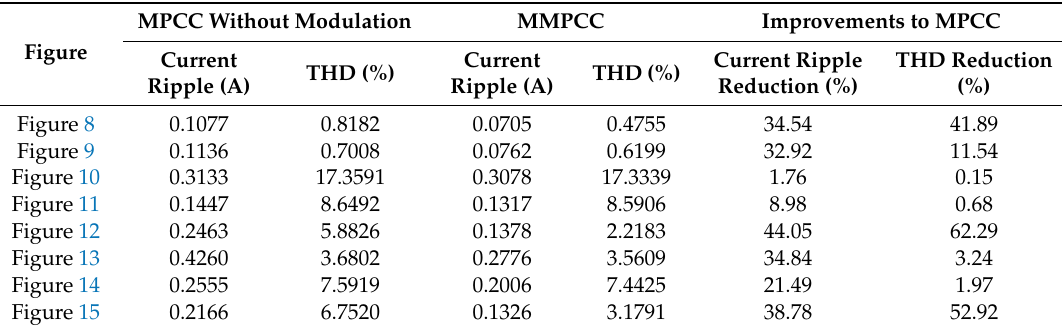
Table 5. Quantitative summary of experimental